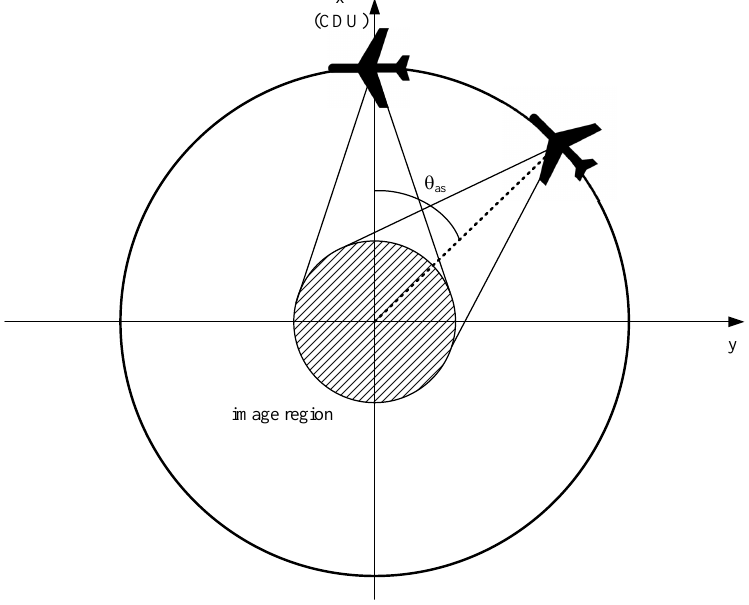
Figure 2. The collection geometry of video SAR on a circular path: top view. CDU: cardinal direction